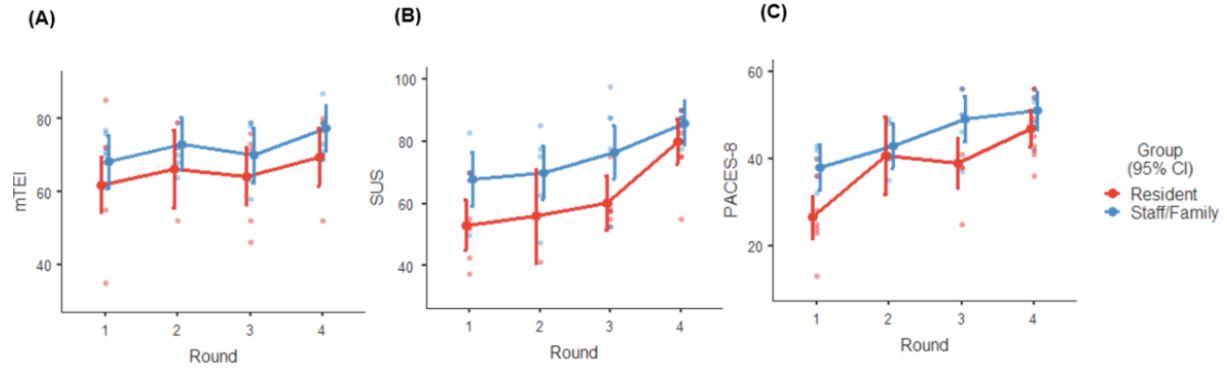
Figure 1. Quantitative measures of (A) acceptability, (B) usability, and (C) physical activity enjoyment among participants across 4 rounds of testing (means and CIs). m-TEI: Modified Treatment Evaluation Inventory; PACES-8: 8-item Physical Activity Enjoyment Scale; SUS: System Usability